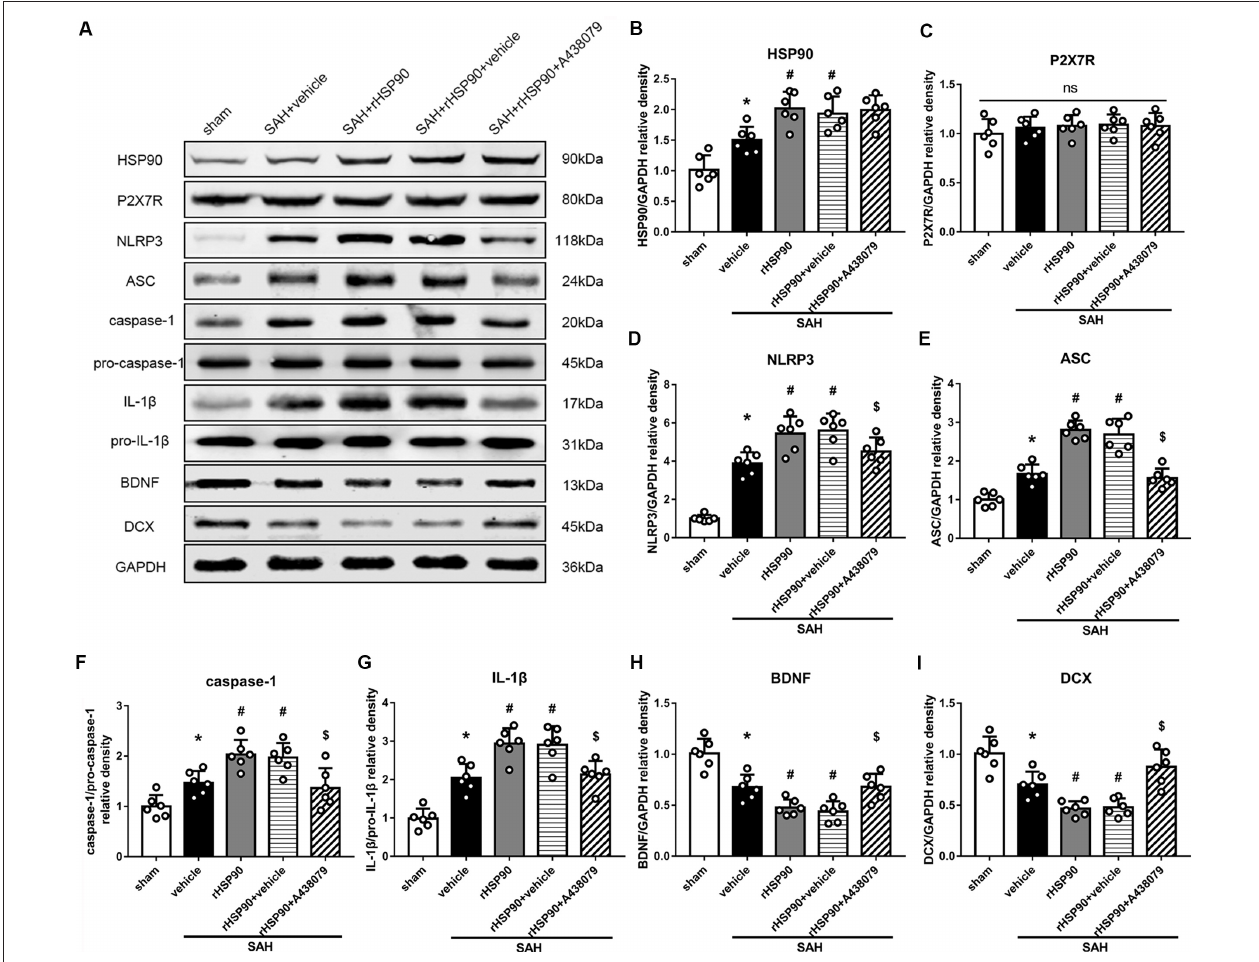
FIGURE 7 | Effects of rHSP90 and P2X7R antagonist A438079 on the expression of HSP90 and its downstream signaling proteins 48 h after SAH. (A) Representative western blots. (B–I) Quantitative analyses of HSP90, P2X7R, NLRP3, ASC, caspase-1, IL-1 β , BDNF and DCX in the left hemisphere; n = 6 per group. ns, no significant. ∗ P < 0.05 vs. sham; # P < 0.05 vs. SAH + vehicle; $ P < 0.05 vs. SAH + rHSP90 + vehicle. The error bars represent